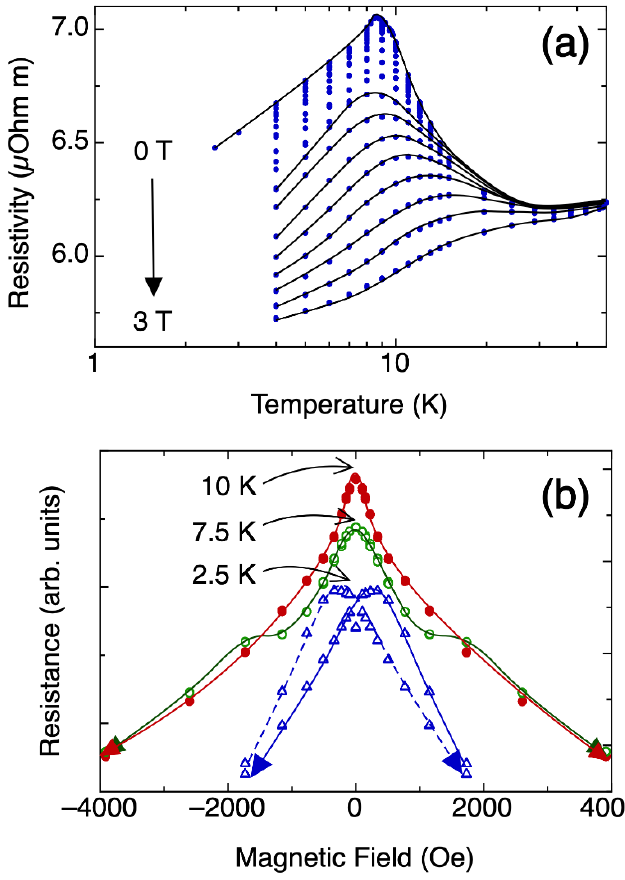
Figure 1. ( a ) Resistivity as a function of temperature in applied magnetic fields from 0 T to 3 T. The solid lines are a guide for the eye. ( b ) Resistance as a function of applied magnetic field for selected temperatures, with arrows indicating the direction of the change in the magnetic field.